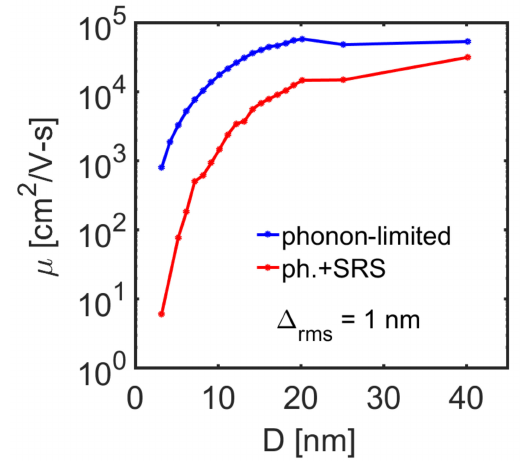
Figure 3. Low-field electron mobility vs. nanowire diameter for [100] InAs nanowires at room temperature. Di ff erent scattering cases are shown: (i) the blue line shows phonon-limited transport (including acoustic and optical deformation potentials scattering and polar optical phonon scattering), (ii) the red line shows the case of when surface roughness scattering (SRS) is added in addition to phonon